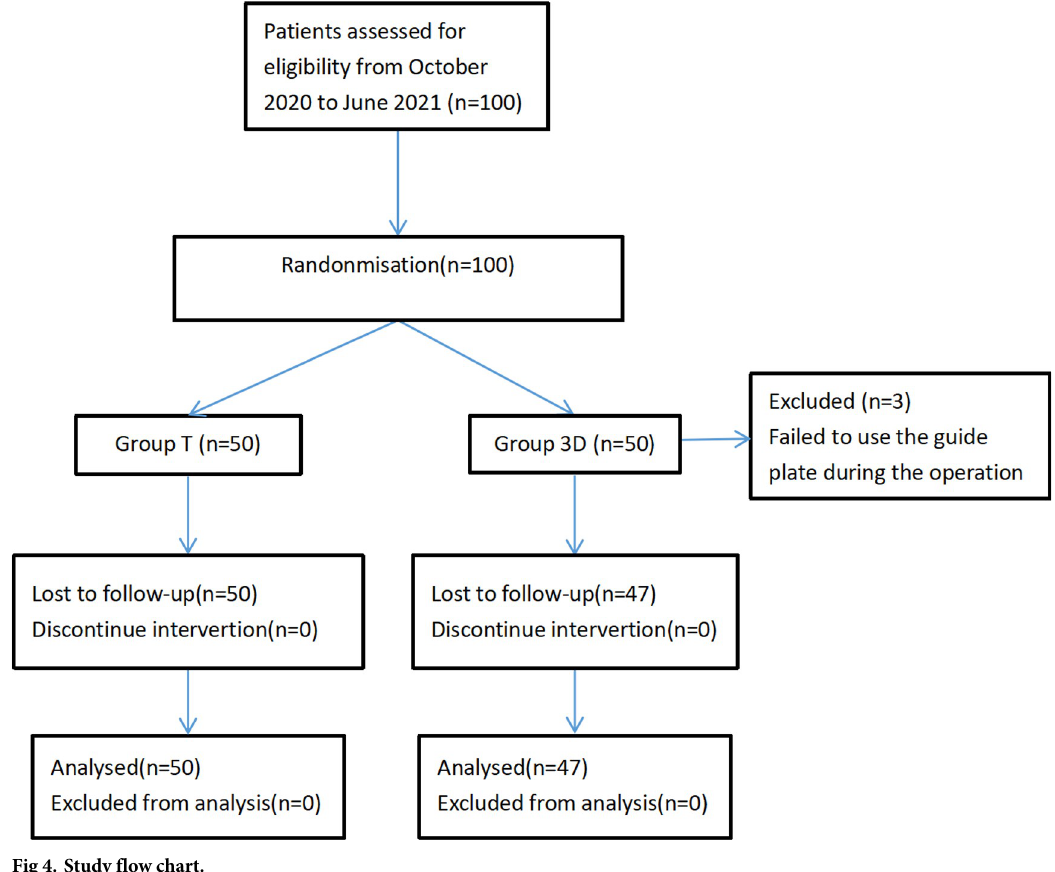
Fig 4. Study flow